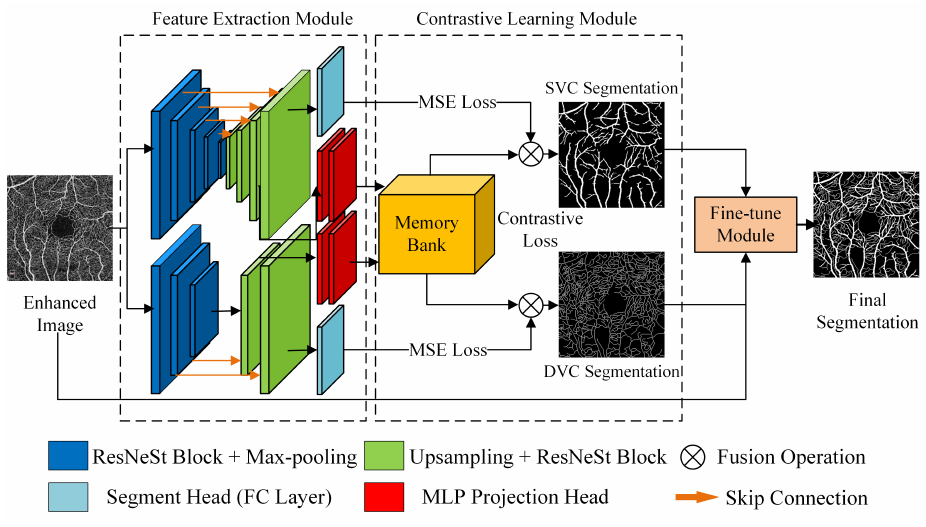
Figure 1. COSNet